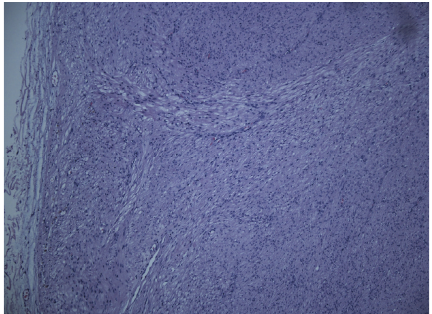
Figure 2: Rem of leiomyoma in relation to urethra,